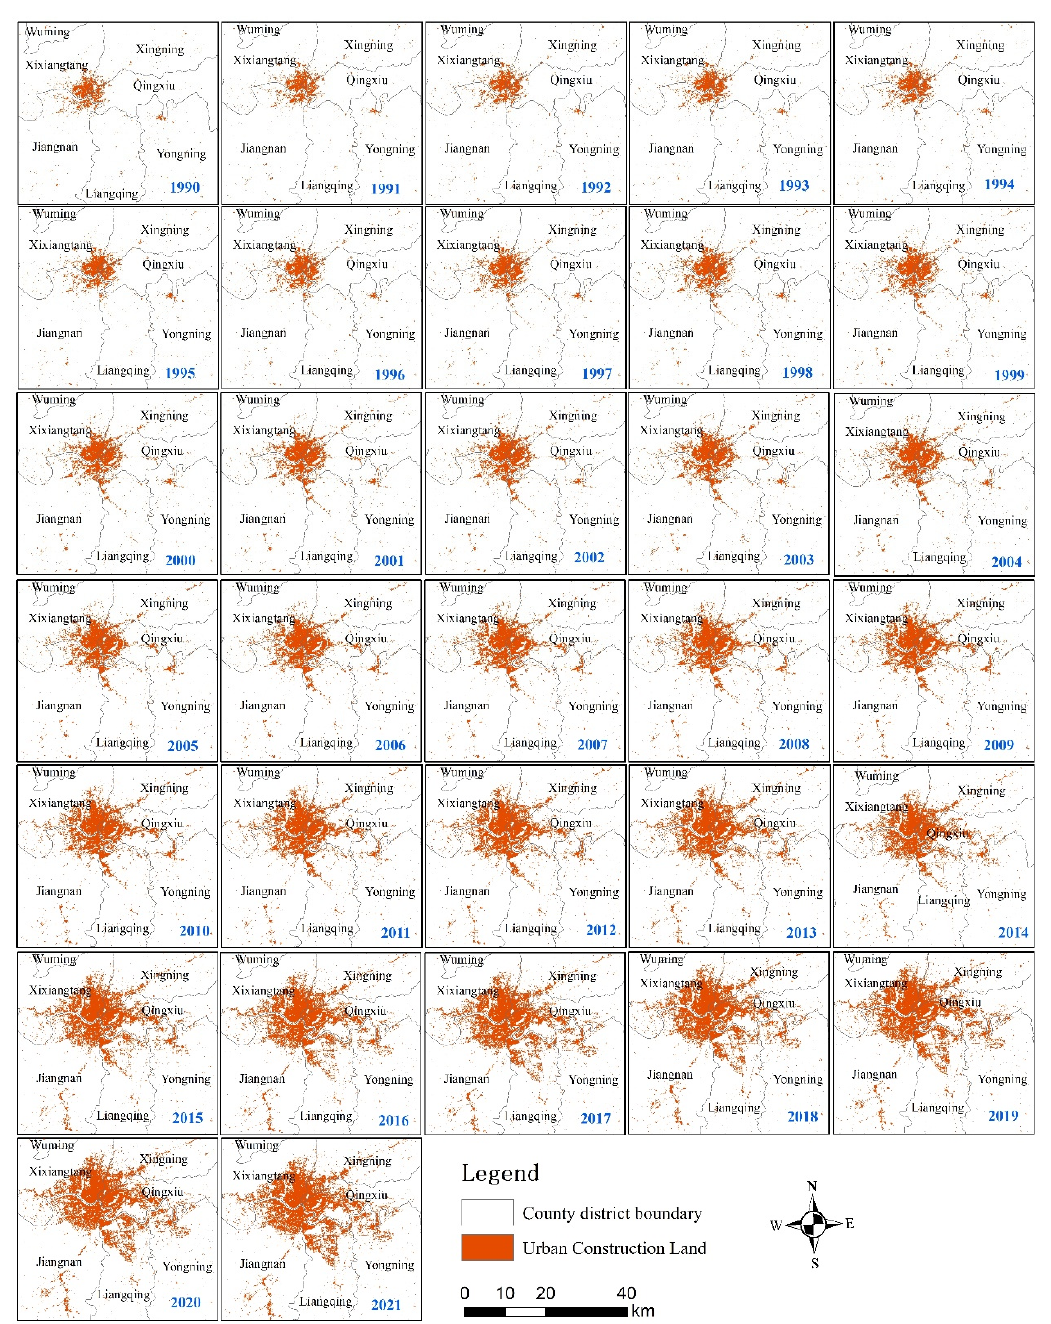
Figure 5. Annual spatial distribution of construction land in Nanning from 1990 to 2021.